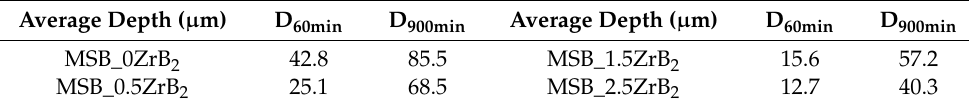
Table 3. Calculated borosilicate layer thickness for selected alloys. Average Depth ( µ